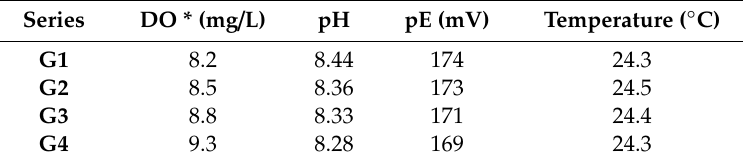
Table 2. The physiochemical properties of the water column in the four experiments. Series DO * (mg / L) pH pE (mV) Temperature ( ◦ C) G1 8.2 8.44